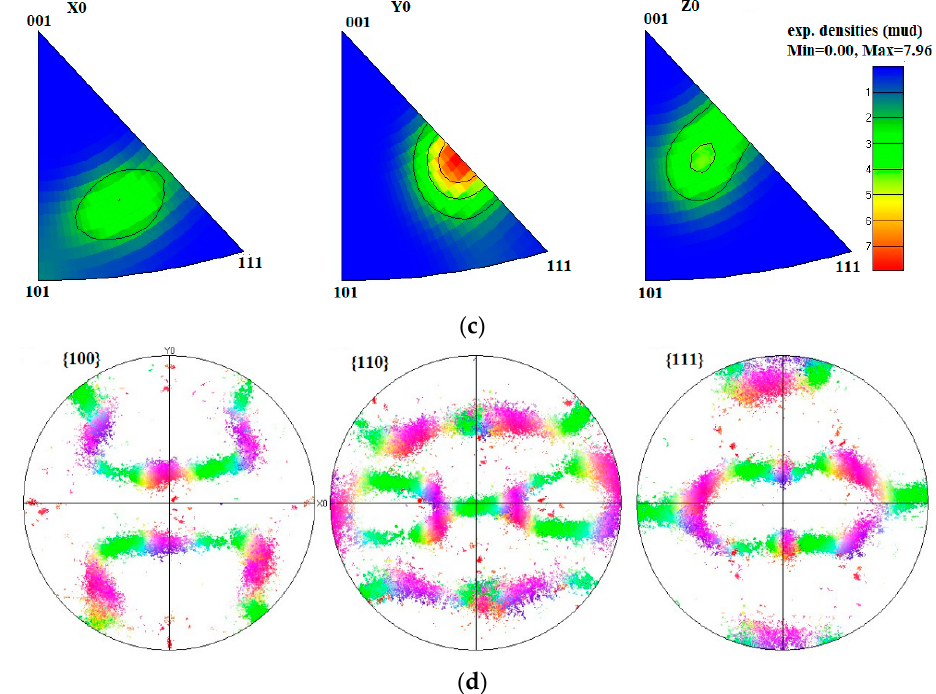
Figure 2. EBSD results for 5Mg0.5Mn0.5Cu alloy after hot-rolling: ( a ) subgrain structure; ( b ) fraction mapping; ( c ) inverse pole figure ( d ) pole figures.